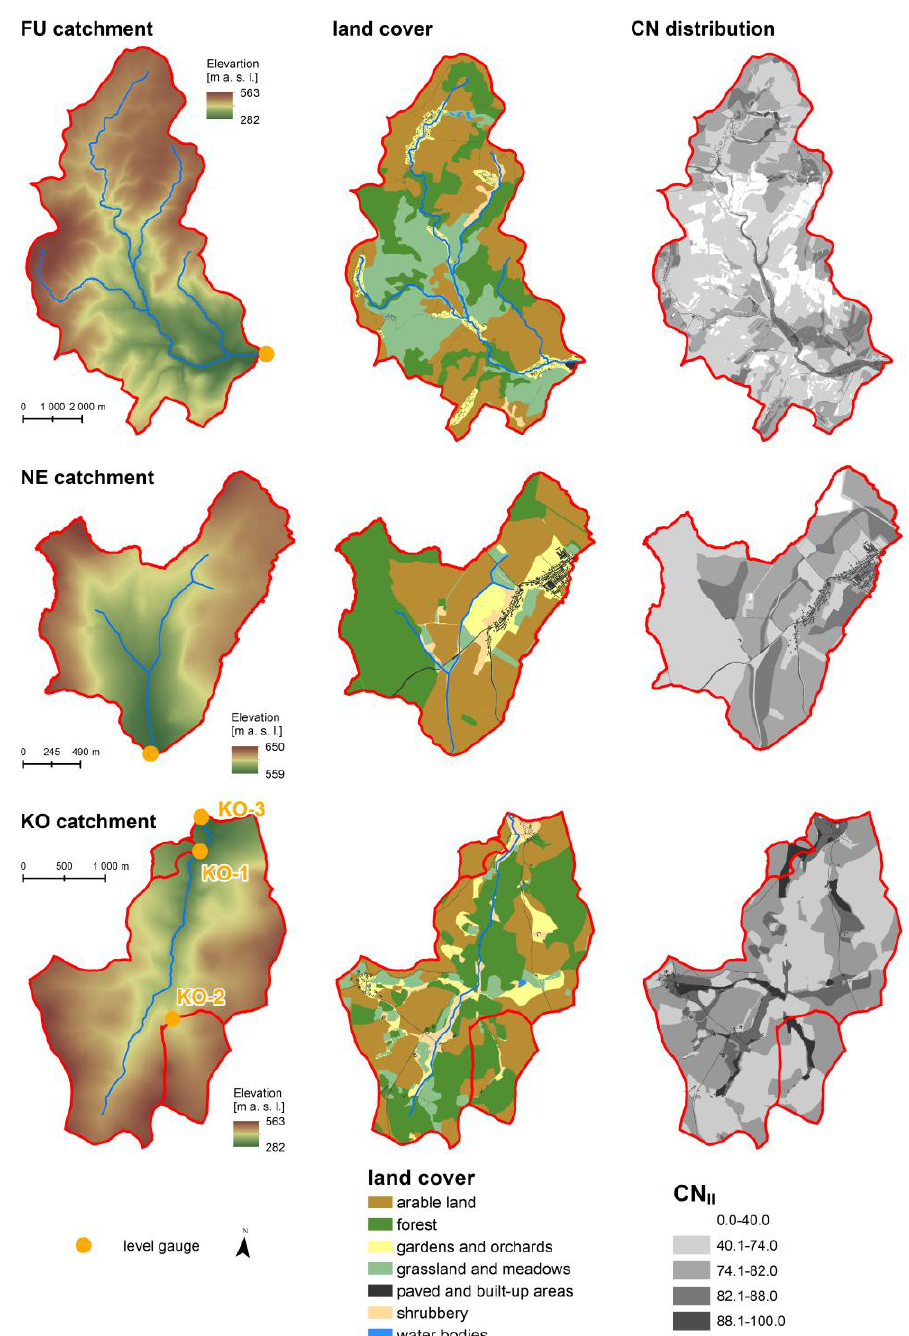
Figure 2. Surface, land cover classification and curve number ( CN ) determination.